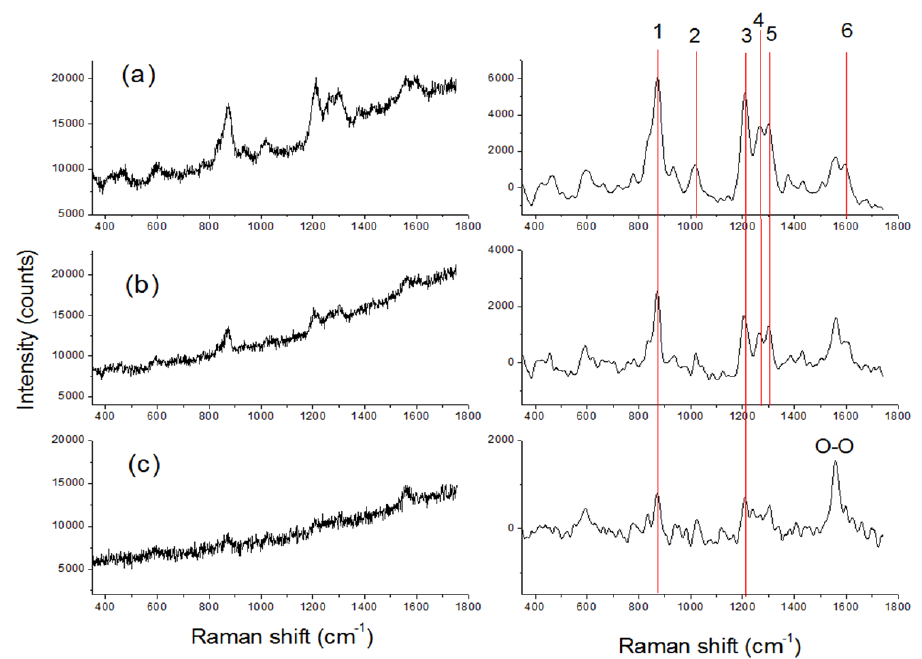
Figure 7. Raw (left) and processed (right) Raman spectra from RDX fingerprints of the 1st ( a ), 3rd ( b ), and 9th ( c ) generation placed on the white varnished metal. Red lines on the left panel indicate the RDX peaks detected automatically by the instrument’s software.